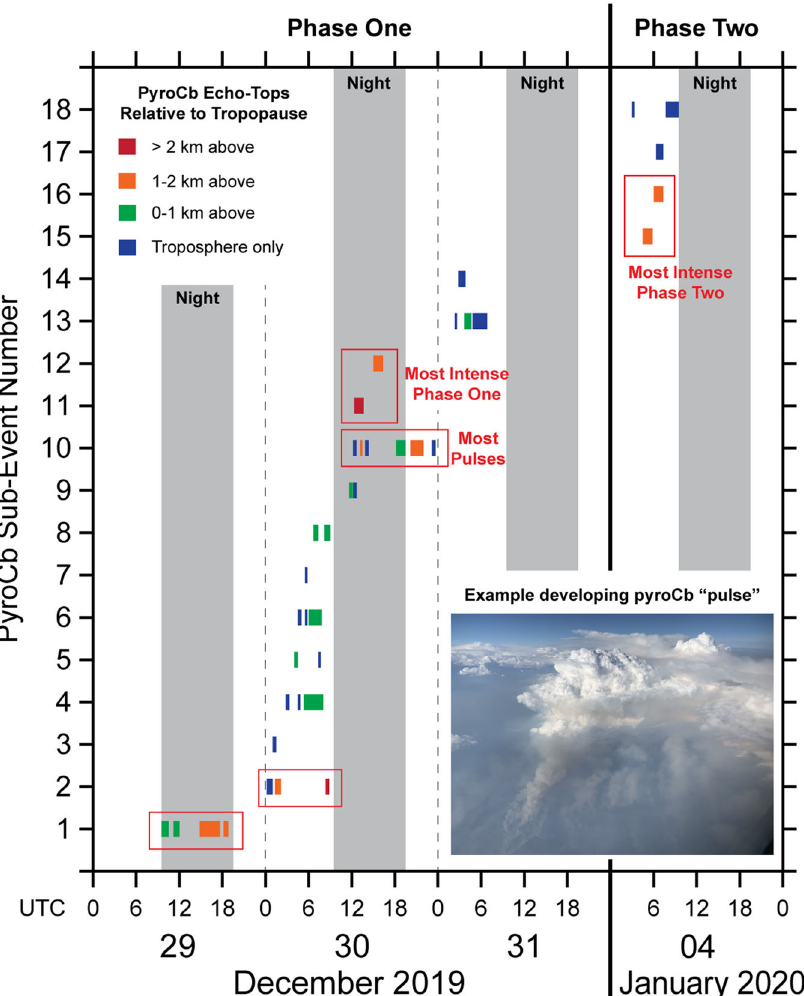
Fig. 4 Timeline of 18 pyroCb sub-events observed during ANYSO. Bars indicate 38 individual pyroCb pulses that injected smoke particles into the UTLS. Each bar includes all 10-min intervals that coincide with AHI BT 11 values below − 35 °C (pyroCb threshold) near each contributing blow-up (displayed in Fig. 1). Shading indicates the maximum radar echo-top altitude of each pulse relative to the tropopause altitude (13.5 km for phase one and 15.0 km for phase two), identifying the 20 pulses that injected smoke directly into lower stratosphere. PyroCb sub-events responsible for the largest stratospheric smoke injections are highlighted with red boxes. Inset picture shows an example pyroCb pulse in its developing stages (taken during the 2019 Fire In fl uence on Regional to Global Environments Experiment - Air Quality (FIREX-AQ) 69 , D.